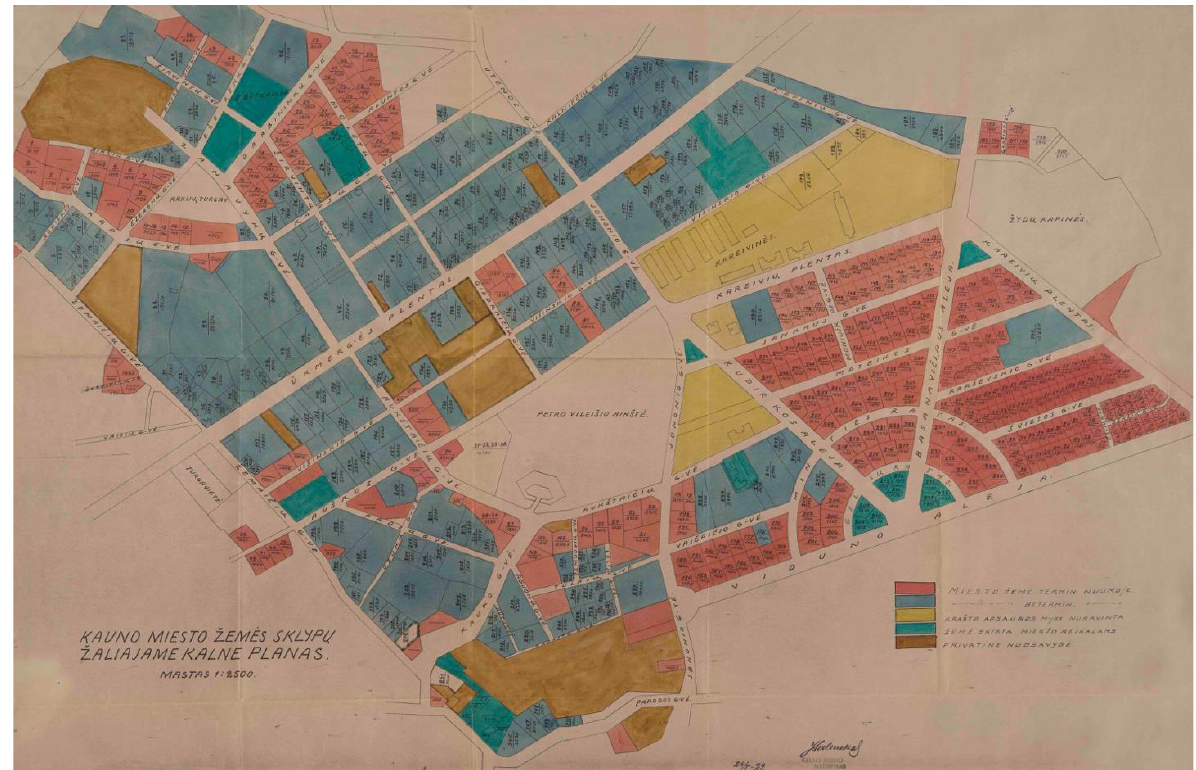
Figure 4. Map of plots in Žaliakalnis, 1929. Red and blue plots belonged to the city and were leased to residents; yellow plots belonged to the Ministry of Defense; dark blue plots were allocated for municipal needs; and brown plots were only allocated for private ownership. Drawing source: Lithuanian Central State Archives.